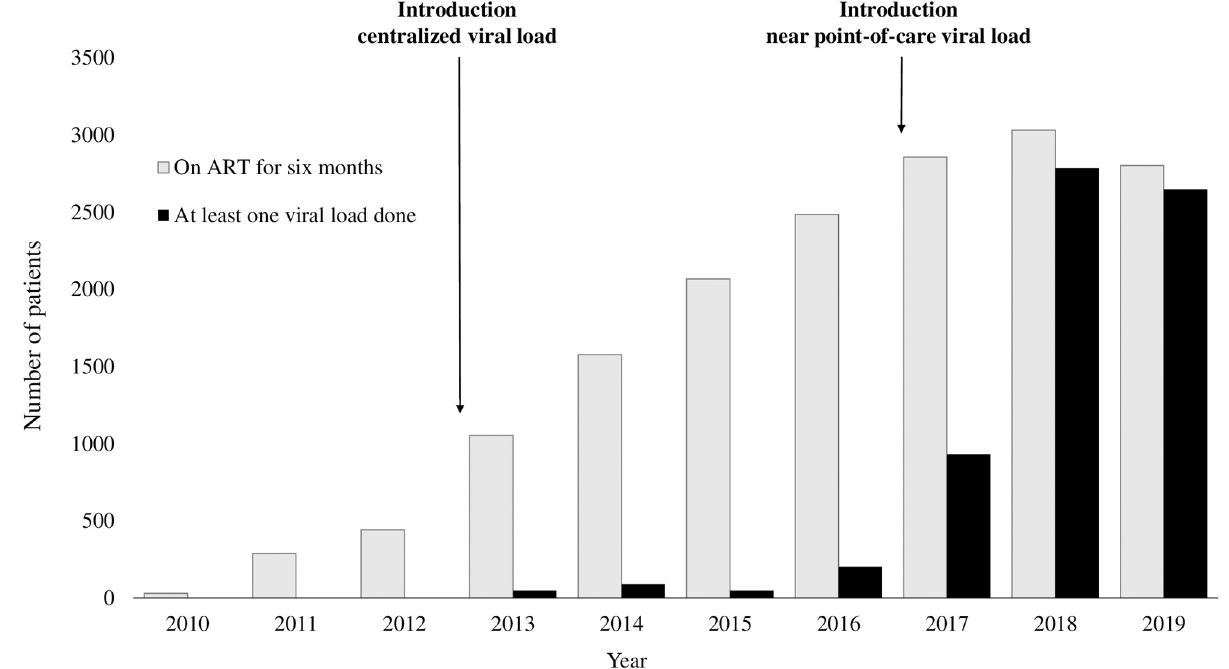
Fig 1. Compliance with yearly VL testing among eligible PLHIV in three clinics in Yangon, Myanmar from 2010 to 2019. ART = antiretroviral therapy, PLHIV = people living with HIV/AIDS.